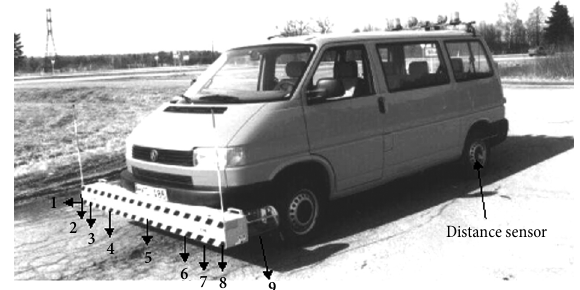
Fig. 2. Laser profilograph DYNATEST 5051 RSP